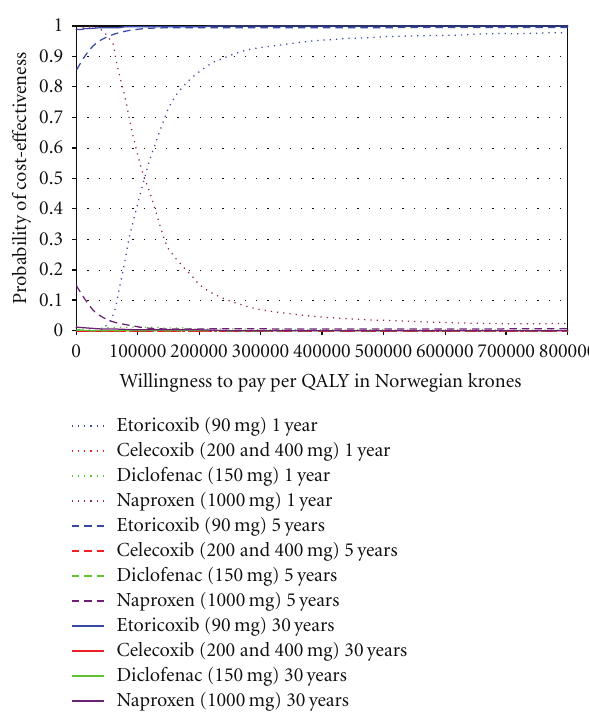
Figure 2: Cost-e ff ectiveness acceptability curves reflecting the probability of cost-e ff ectiveness for etoricoxib, celecoxib (200 & 400 mg), diclofenac, and naproxen at a followup of 1 year, 5 years, and 30 years (base-case